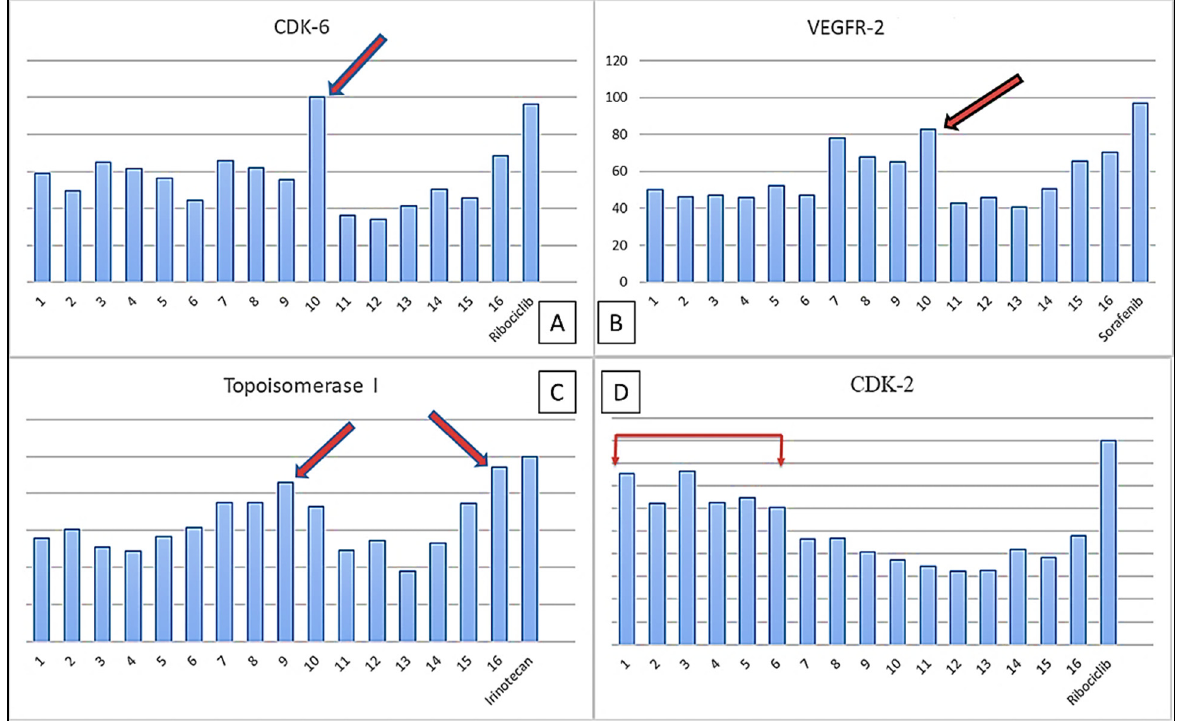
Figure 9. ( A ) The relative percentage of the binding affinity of quercetin-3- O -xyloside compared to other isolated constituents against CDK-6 target; ( B ) The relative percentage of the binding affinity of quercetin-3- O -xyloside and other isolated constituents against VEGFR-2 target; ( C ) The relative percentage of the binding affinity of both luteolin-7- O -glucoside and quercetin-3- O -glucoside compared to other isolated constituents against topoisomerase 1 target; ( D ) The relative percentage of the binding affinity of the triterpenoidal and steroidal compounds and other isolated constituents against CDK-2 target.